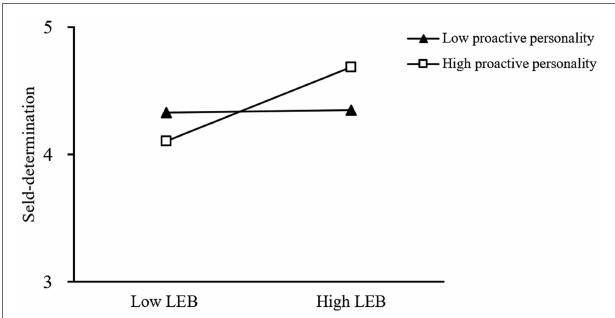
FIGURE 2 | Simple Slope of Proactive Personality. LEB means leader empowering